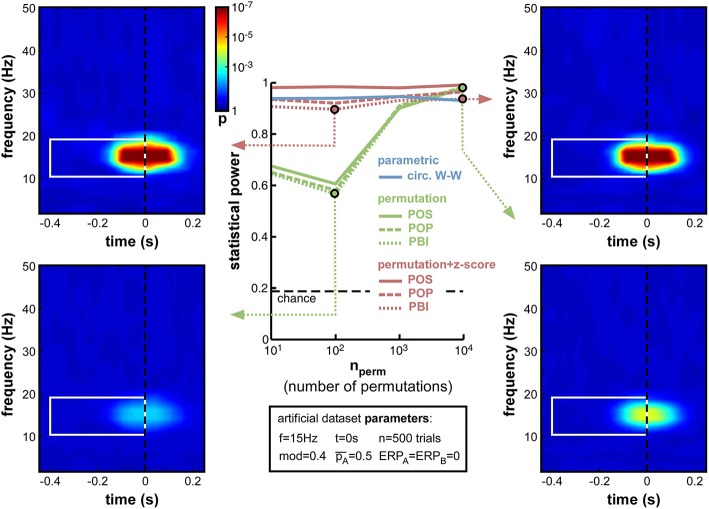
Effect of varying permutation number. Artificial dataset creation parameters are identical to those used in Figure 5, with the depth of oscillatory modulation set at mod = 0.4. All four time-frequency maps illustrate the results of the PBI measure. Using a hybrid permutation + z-score test, PBI produces comparable results with 100 or 10,000 permutations (top-left and top-right). Using a standard permutation test, however, with 100 permutations the target p-values are hardly distinguishable from the background noise (bottom-left), whereas statistical power can be restored with 10,000 permutations (bottom-right).